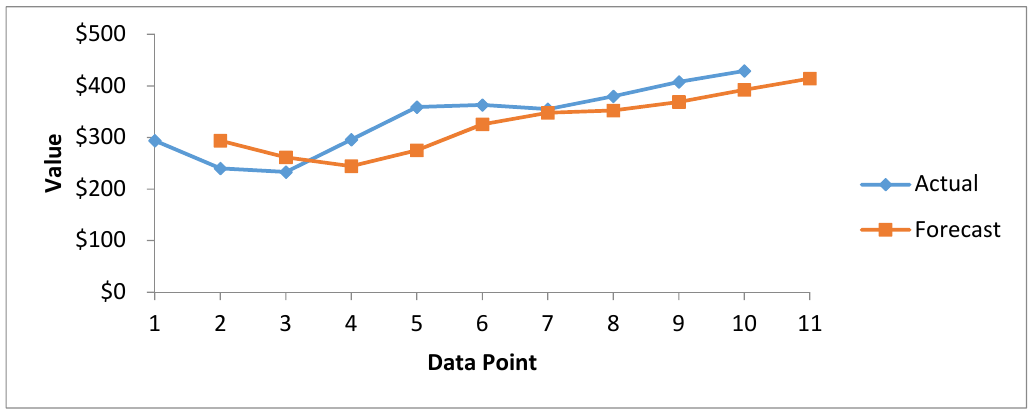
Figure 10. Forecasting graph of Healthcare Record Costs from 2010–2020 Using the SES method.